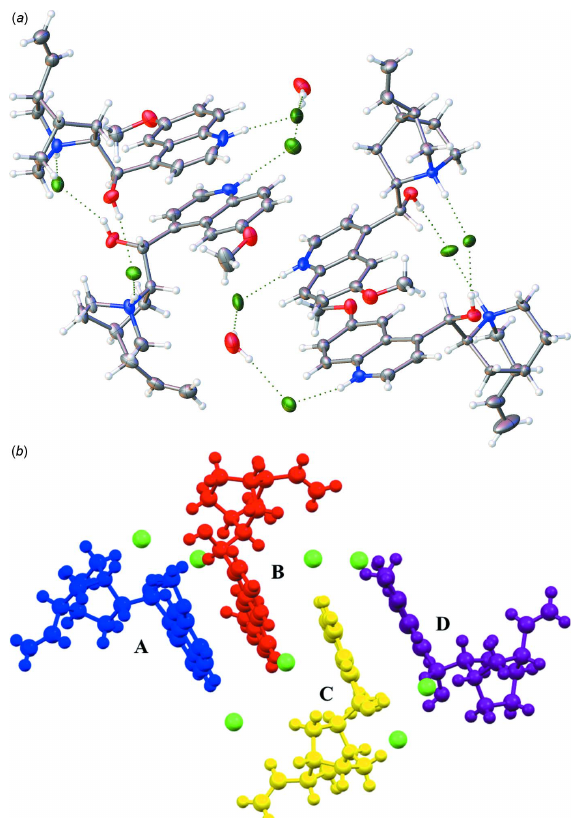
Figure 2 ( a ) The asymmetric unit of the title compound shown with 50% probability ellipsoids. Disorder is omitted for clarity. ( b ) The asymmetric unit of the title compound colored to define the distinct cation pairs A and B (blue and red) and C and D (yellow and purple) discussed in the manuscript.